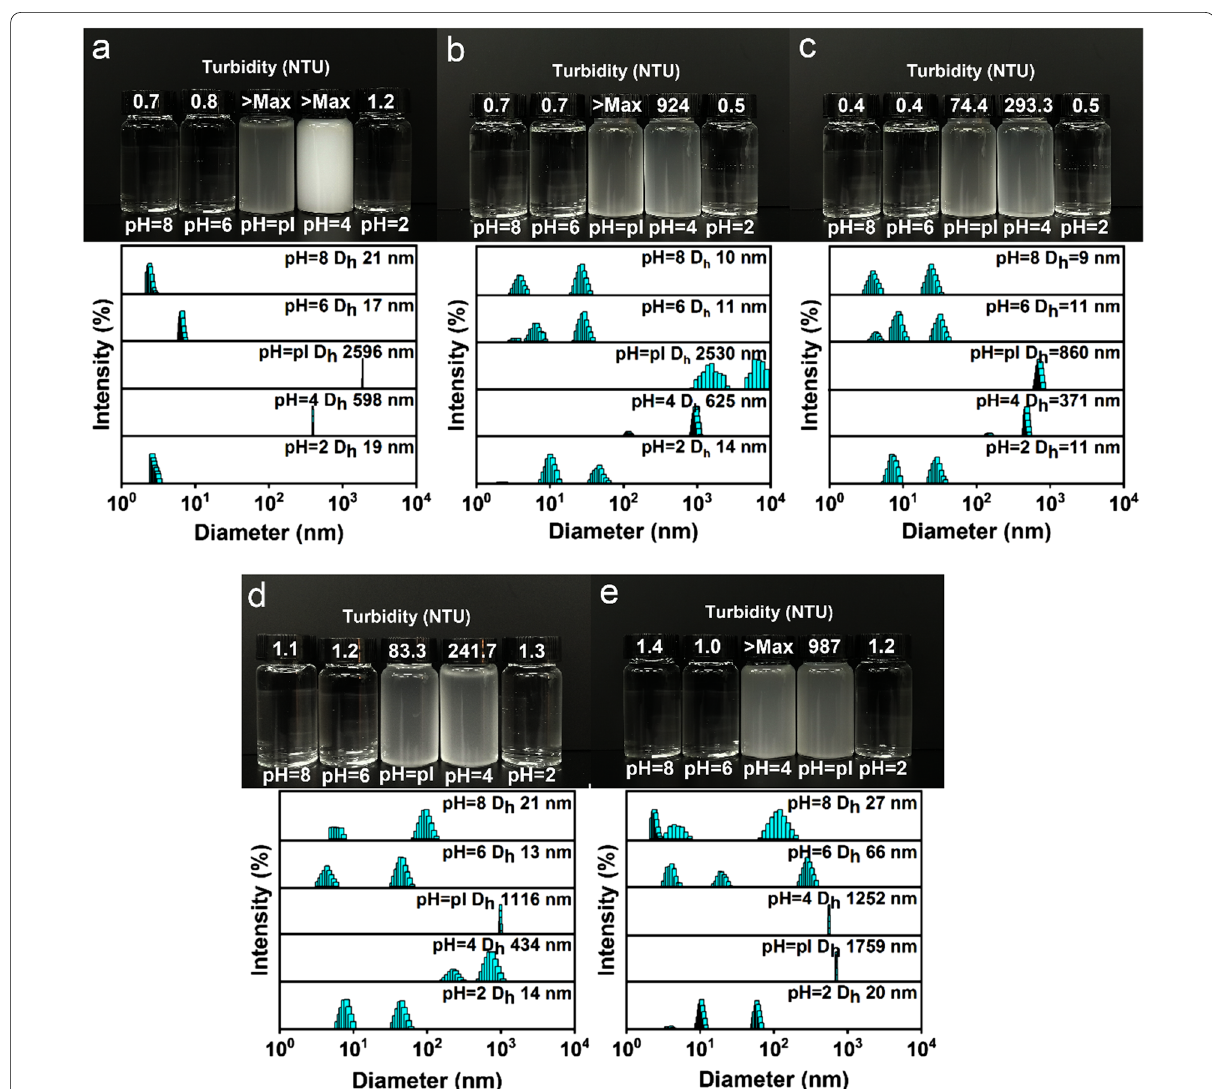
Fig. 2 Particle size distribution and turbidity of Poly (AA‑co‑DAC) ( a ), Poly (AA‑co‑DMC) ( b ), Poly (AA‑co‑MAPTAC) ( c ), Poly (AA‑co‑DMAPMA) ( d ) and Poly (AA‑co‑DMAEMA) ( e ) under different pH